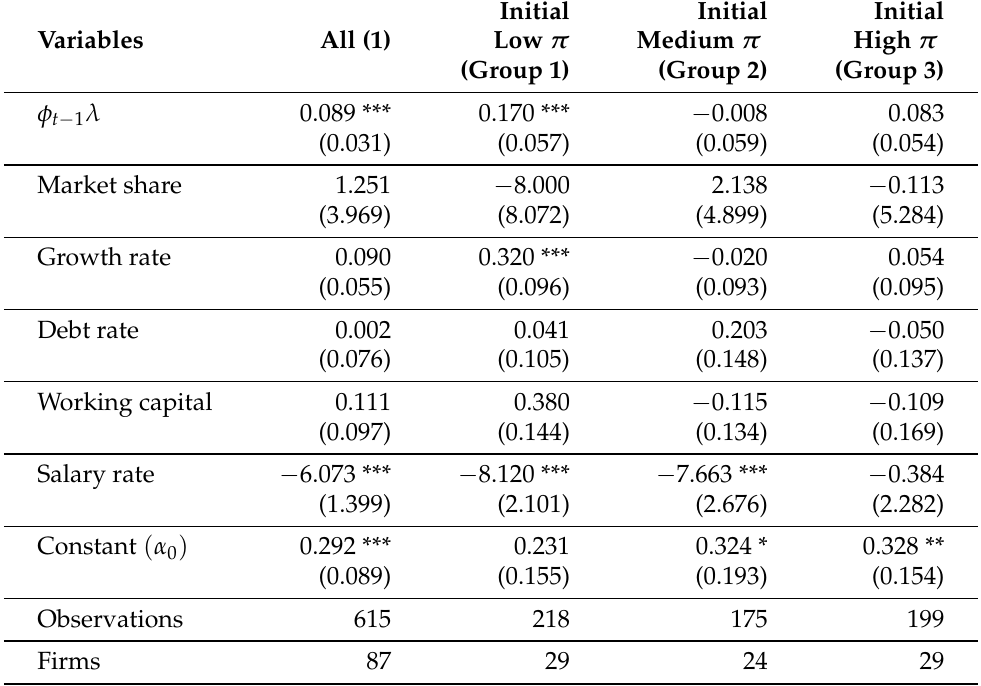
Table 6. Result from Model 3b (including salary as explanatory